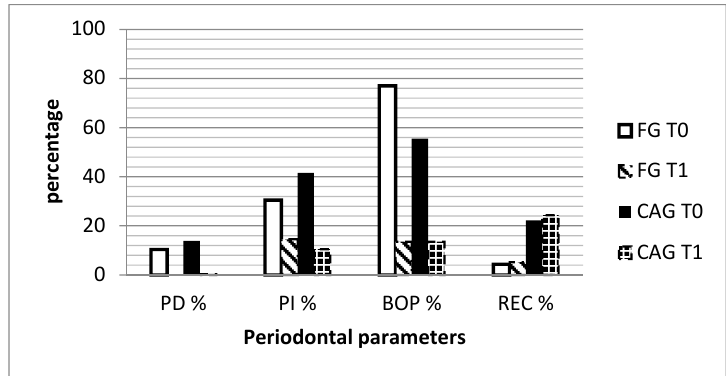
Figure 1. Graph describing the mean % of the four periodontal parameters assessed at baseline (T0) and at 3 month follow-up (T1) in the two groups. FG: fixed group; CAG: clear aligners group; PD: probing depth, PI: plaque index, BOP: bleeding on probing; REC: gingival recession.